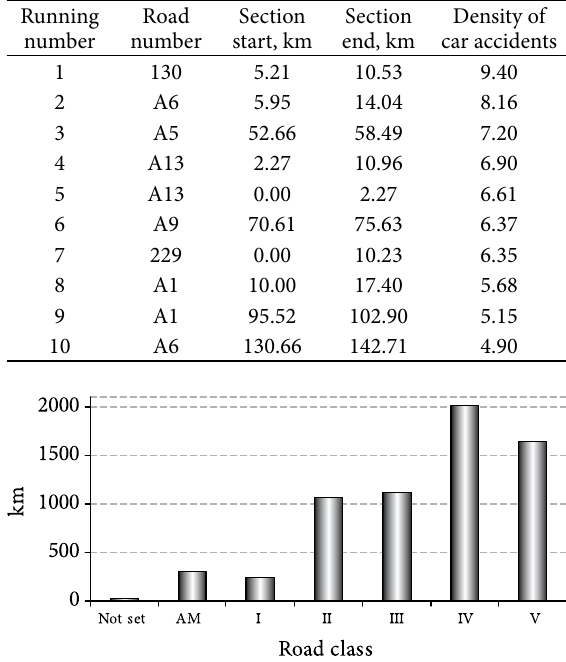
Fig. 1. Lithuanian main and interurban road network considering road